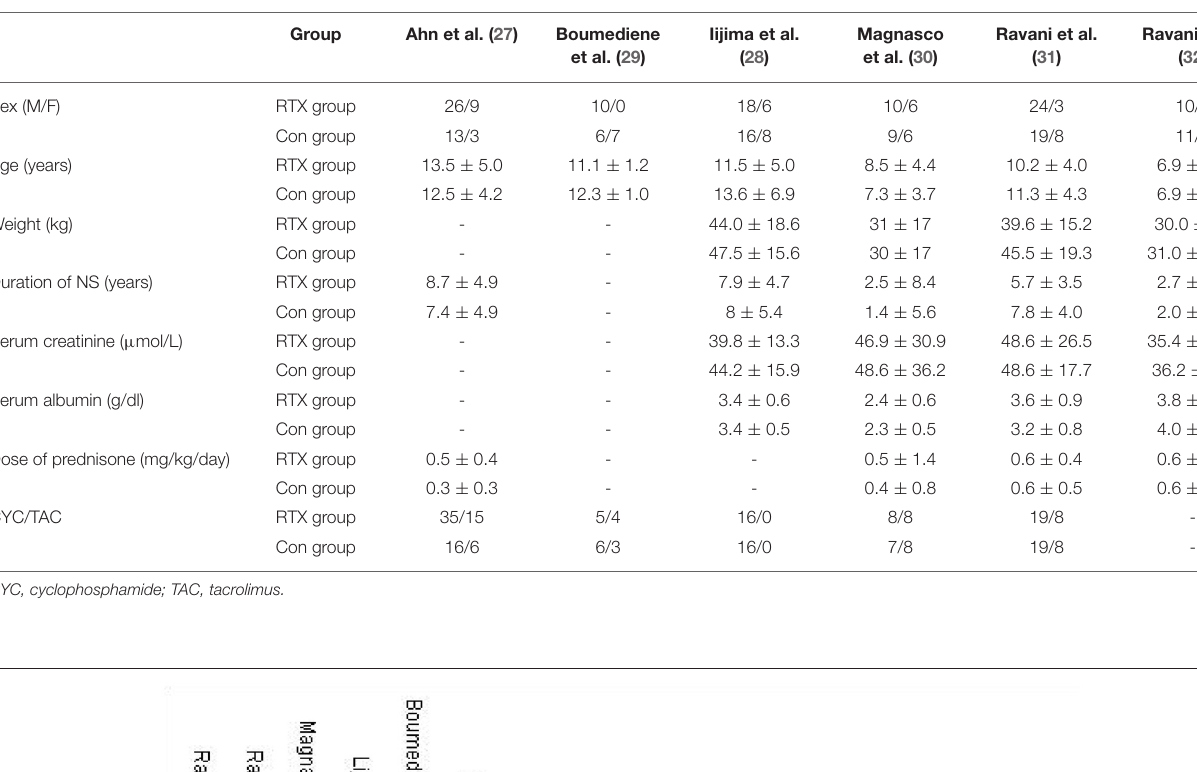
TABLE 2 | Basic characteristics of included studies.